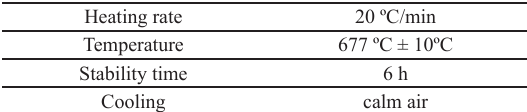
Figure 2. Dissimilar ASTM A183 F22 steel – Inconel 625 –ASTM A36 steel, welded joint showing the extraction direction of the tensile test specimens. Table 6. PWHT parameters.